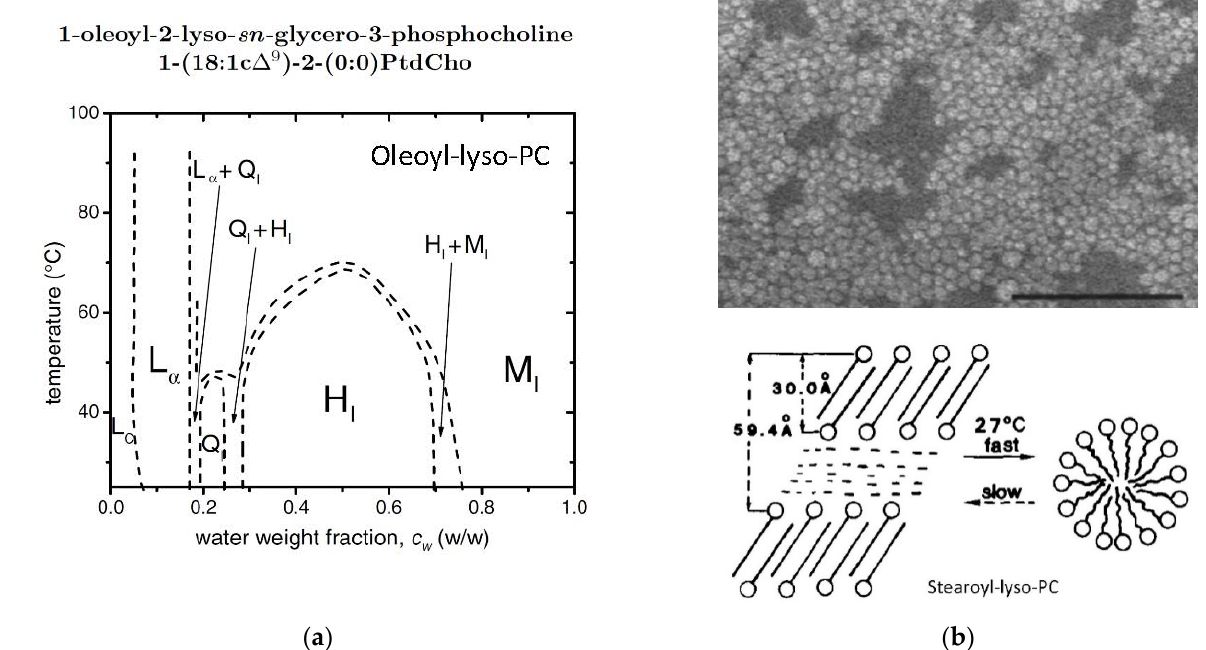
Figure 9. Aqueous solutions and dispersions of oleoyl-lyso-PC (or stearoyl-lyso-PC). ( a ) Binary oleoyl-lyso-PC/water phase diagram, as published by Marsh (2013) [84], a mirror image of the diagram originally published by Arvidson et al. (1985) [85]. Regions of the isotropic micellar phase (usually denoted by L 1 ) are labeled with M I , of the hexagonal phase with H I , and of the cubic phase with Q I . “1-oleoyl-2-lyso- sn -glycero-3-phosphocholine” is another description for oleoyl-lyso-PC. A water weight fraction of 0.8, for example, means 80 wt% water. ( b ) Top : A micellar solution of 10 mM (~0.5 wt%) egg lyso-PC (obtained from egg yolk phosphatidylcholine after treatment with phospholipase A 2 to remove the acyl chain in position sn -2 in the PC molecules), prepared in physiological saline, was analyzed by negative staining transmission electron microscopy in the dry state at room temperature (bar: 100 nm; stained with sodium phosphotungstate); see Inoue et al. (1977) [86]. The presence of spherical micelles (with a fluid core) is evident from the electron micrograph. Bottom : Schematic representation of the temperature-dependent aggregation behavior of dilute aqueous dispersions of stearyol-lyso-PC. Stearoyl-lyso-PC forms spherical micelles at elevated temperature and “interdigitated” bilayer structures at low temperature. In the interdigitated bilayer state, the stearoyl chains interpenetrate; see Mattai and Shipley (1989) [87]. Reproduced from [84], copyright © Taylor and Francis, 2013; from [86], copyright © Oxford University Press, 1977; and with permission from [87], Elsevier,